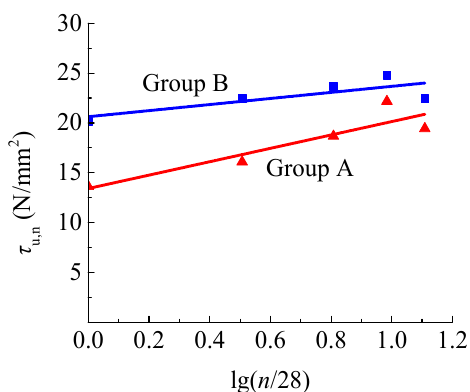
Figure 11. Changes of bond strength with soaking time.